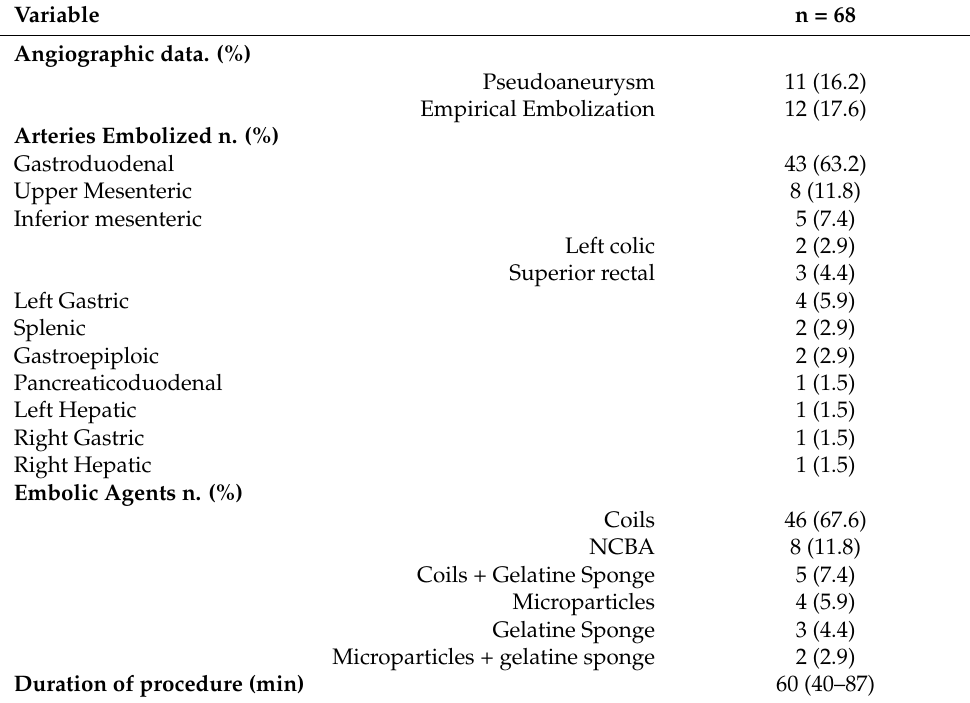
Table 3. Per procedure characteristics of the 68 patients.